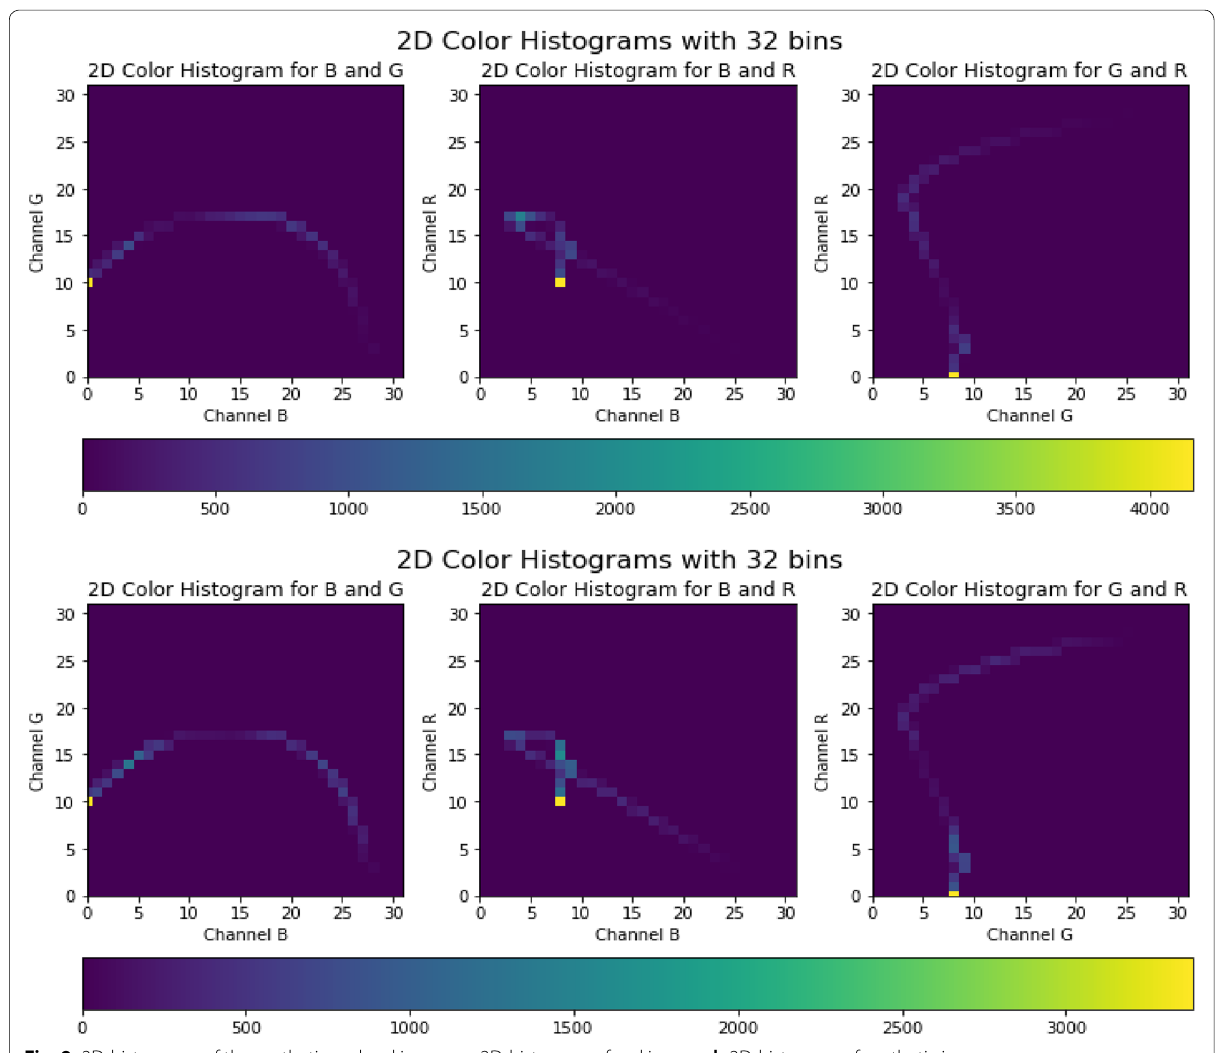
Fig. 9 2D-histograms of the synthetic and real images. a 2D-histogram of real images, b 2D-histogram of synthetic